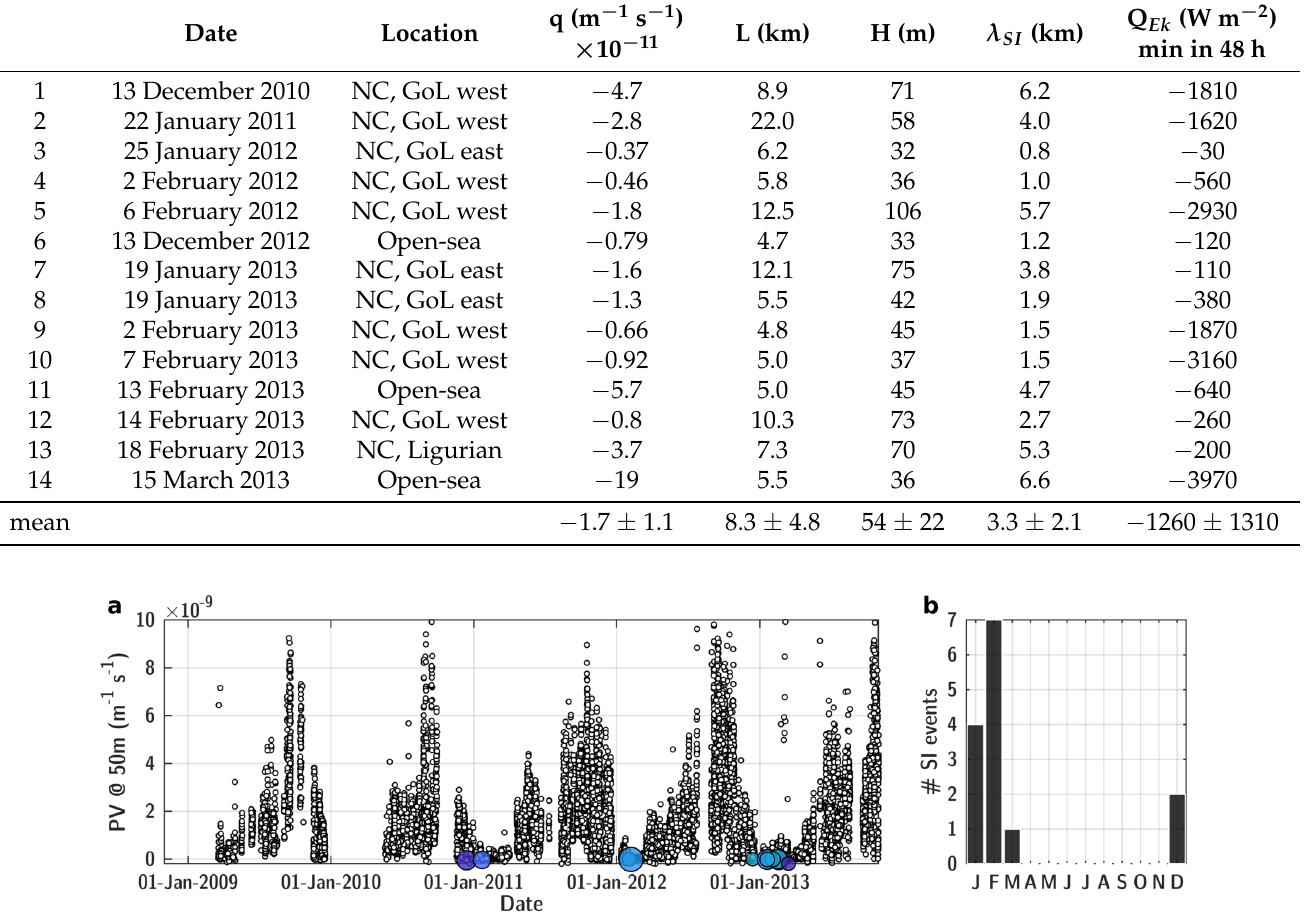
Table 2. Characteristics of frontal SI events detected by glider: q , L , H correspond to the mean PV, width and thickness; λ SI refers to the theoretical SI wavelength; Q Ek is the minimum Ekman equivalent heat flux observed along the glider-track within a 48 h window around each event.